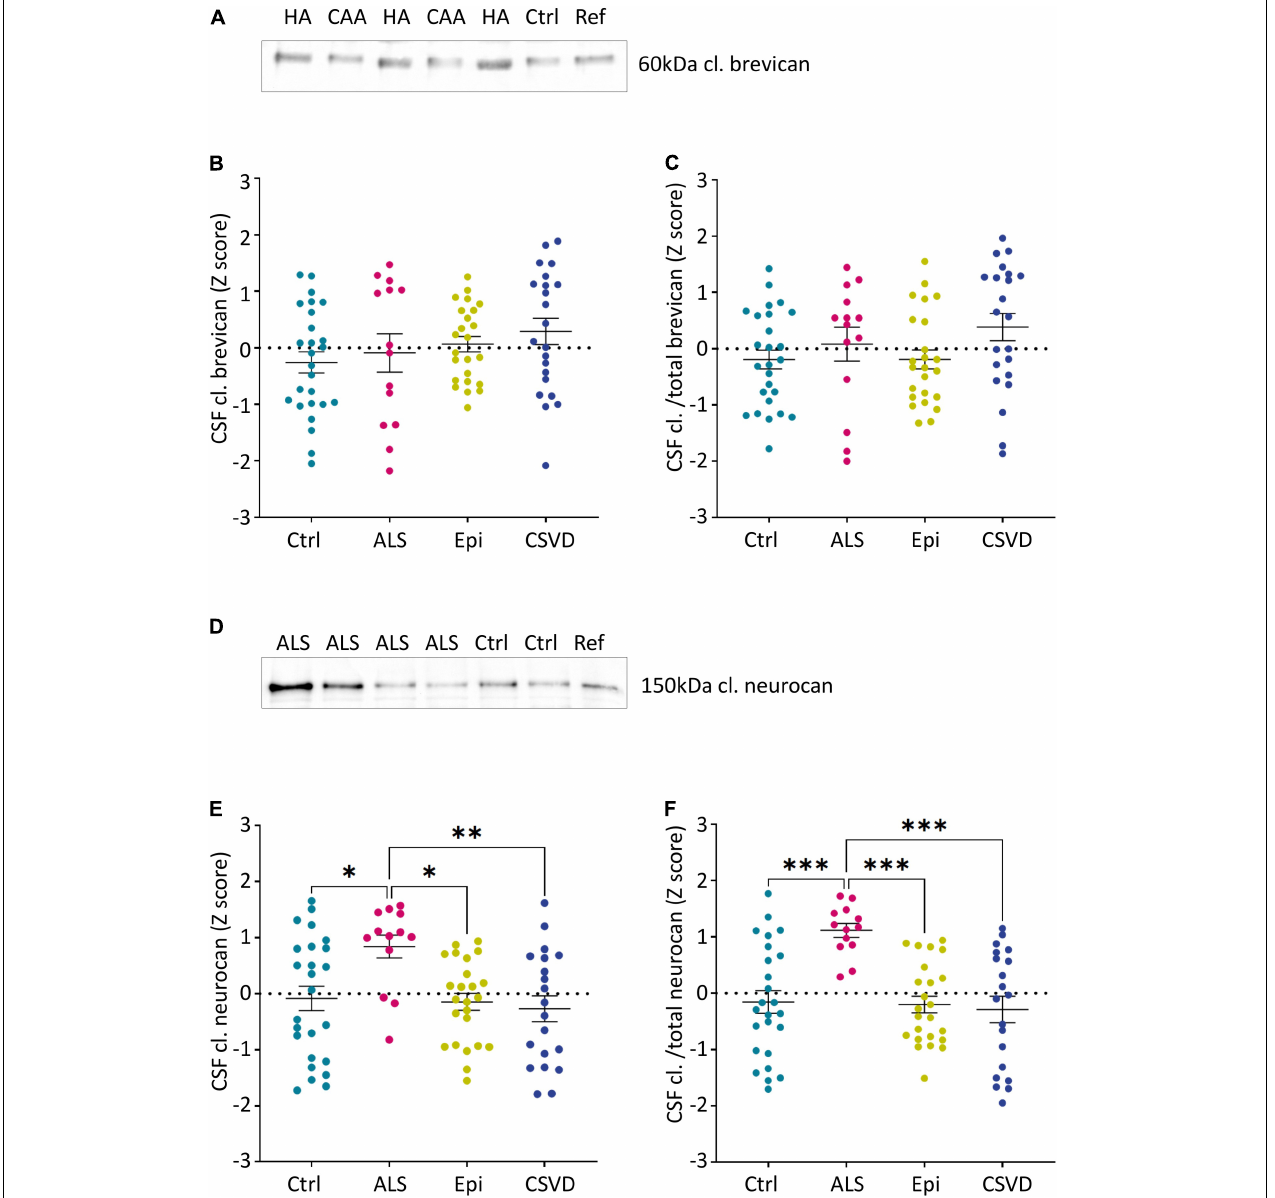
FIGURE 4 | Group-wise comparison of z-scores from age- and sex-corrected CSF levels of the 60 kDa brevican fragment (A–C) and the 150 kDa neurocan-C fragment (D–F) as measured via immunoblots (normalized to controls). Cutouts of example western blots of cleaved brevican (A) and neurocan (D) immunoreactivity in individual CSF samples and a reference sample loaded on all gels for calibration. (C) and (F) show the ratios of cleaved brevican (B) and cleaved neurocan (E) to the total immunoreactivity determined for these proteoglycans (CSF cl.BCAN and cl./total BCAN: Ctr. n = 26, ALS n = 14, Epi n = 24, CSVD n = 22; CSF cl. NCAN and CSF cl./total NCAN: Ctr. n = 25, ALS n = 13, Epi n = 24, CSVD n = 20). Statistical significance is indicated (* p ≤ 0.05, ** p ≤ 0.005, *** p ≤ 0.0005, **** p < 0.0001). Ctrl, control; ALS, amyotrophic lateral sclerosis; Epi, epilepsy; CSVD, cerebral small vessel disease; HA, hypertensive arteriopathy; CAA,